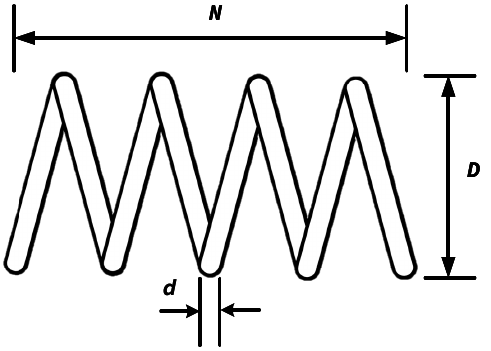
Figure 4. Tension/compression spring design problem.